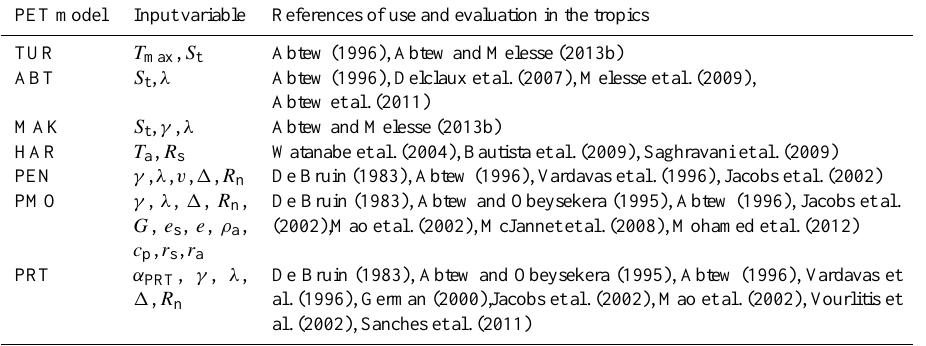
Table 1. Input variables of all potential evaporation (PET) models utilized in this study and references where used and evaluated previously in the tropics (TUR = Modified Turc equation, ABT = Simple Abtew equation, MAK = Modified Makkink equation, HAR = Hargreaves equation, PEN = Penman open water evaporation, PMO = Penman–Monteith combination equation, PRT = Priestley–Taylor equation).